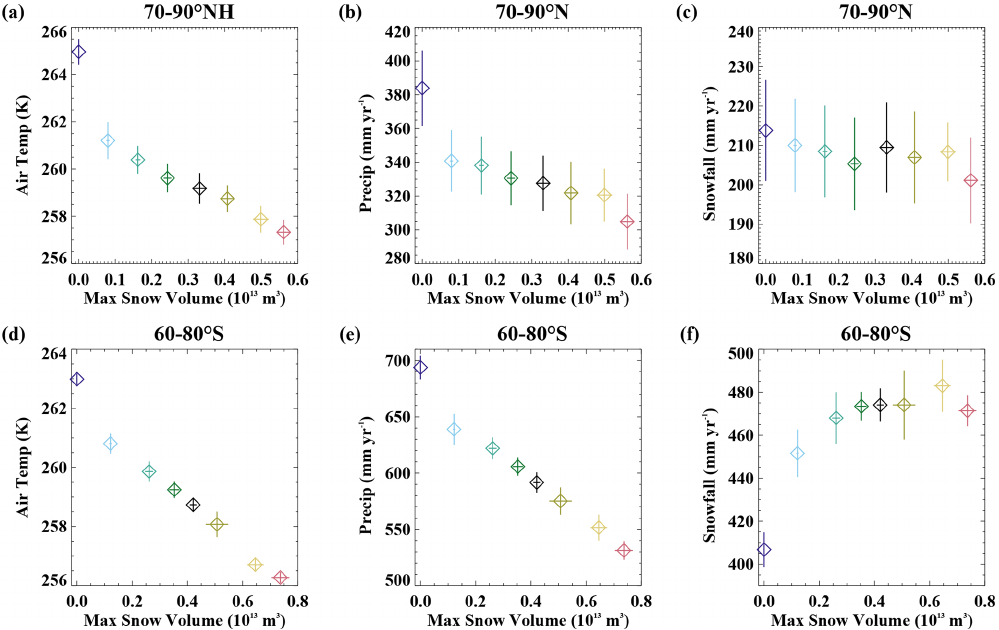
Figure 7. The relationship of the climatological 70–90 ◦ N (a) annual average surface air temperature, (b) annual total precipitation, and (c) annual total snowfall versus the annual maximum Northern Hemisphere volume of snow on sea ice across the simulations. Bottom panels show conditions for 60–80 ◦ S versus the Southern Hemisphere snow volume for (d) annual mean surface air temperature, (e) annual total precipitation, and (f) annual total snowfall. The whiskers show ± 1 standard deviation across the 20 years analyzed for each simulation.